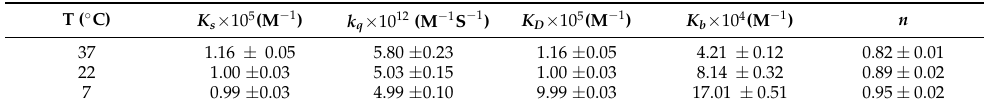
Table 4. Thermodynamic parameters obtained by plotting Van’t Hoff, showing that both enthalpy and entropy are negative. It defines that there must be hydrogen bonds and Van der Waals